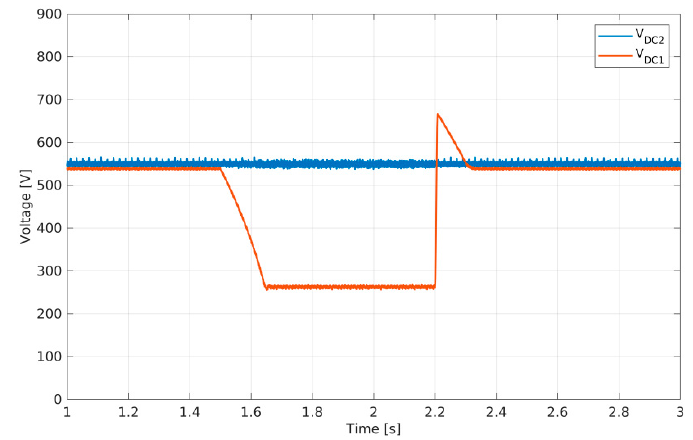
Figure 8. In the DC sides of the two inverters with a voltage sag of 30%.